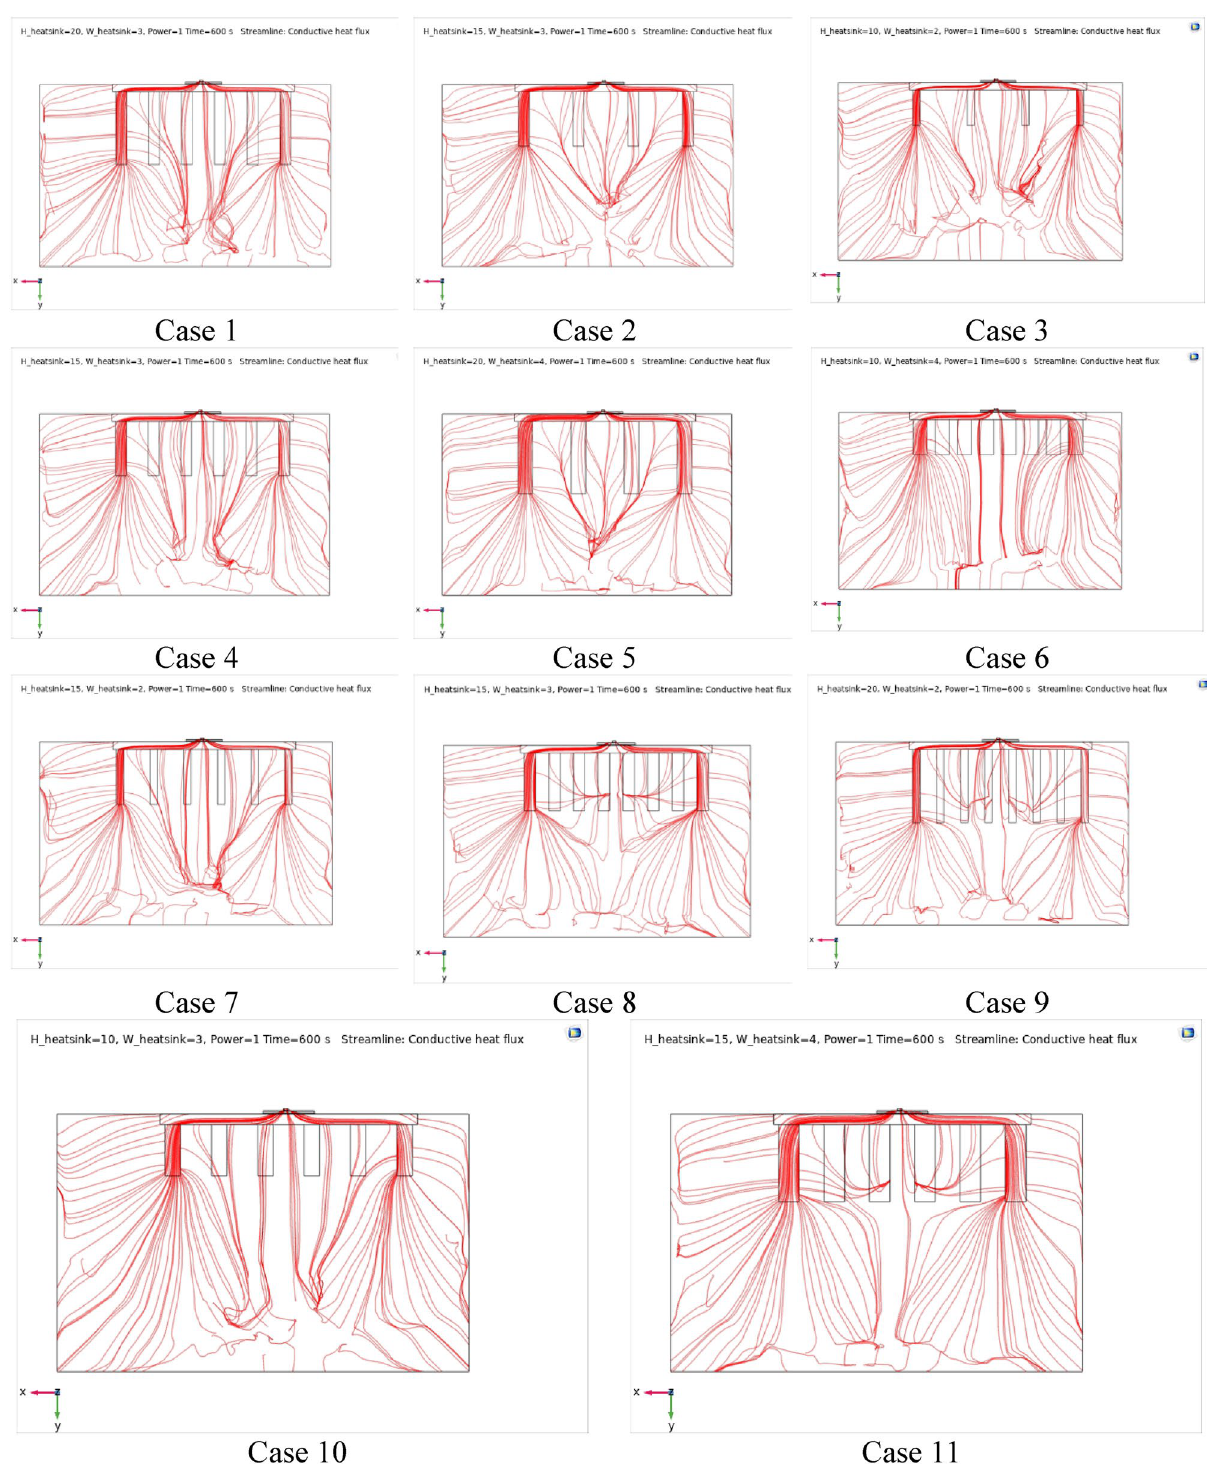
Figure 8. 2D Streamline contours for the finned micro-channel of different geometries (11 Cases) (COMSOL Multiphysics 5.6, https:// www. comsol.